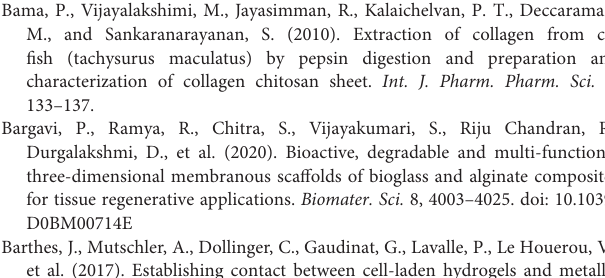
Supplementary Figure 1 | MicroCT images of calvarial defects at different time points. Supplementary Figure 2 | XPS examination on two types of composite scaffolds: (A) Typical XPS survey spectrum of 67%DCP/ADC; (B) Typical XPS survey spectrum of 67%DCP/ATM; (C) Atomic percentages (%) of different elements measured by